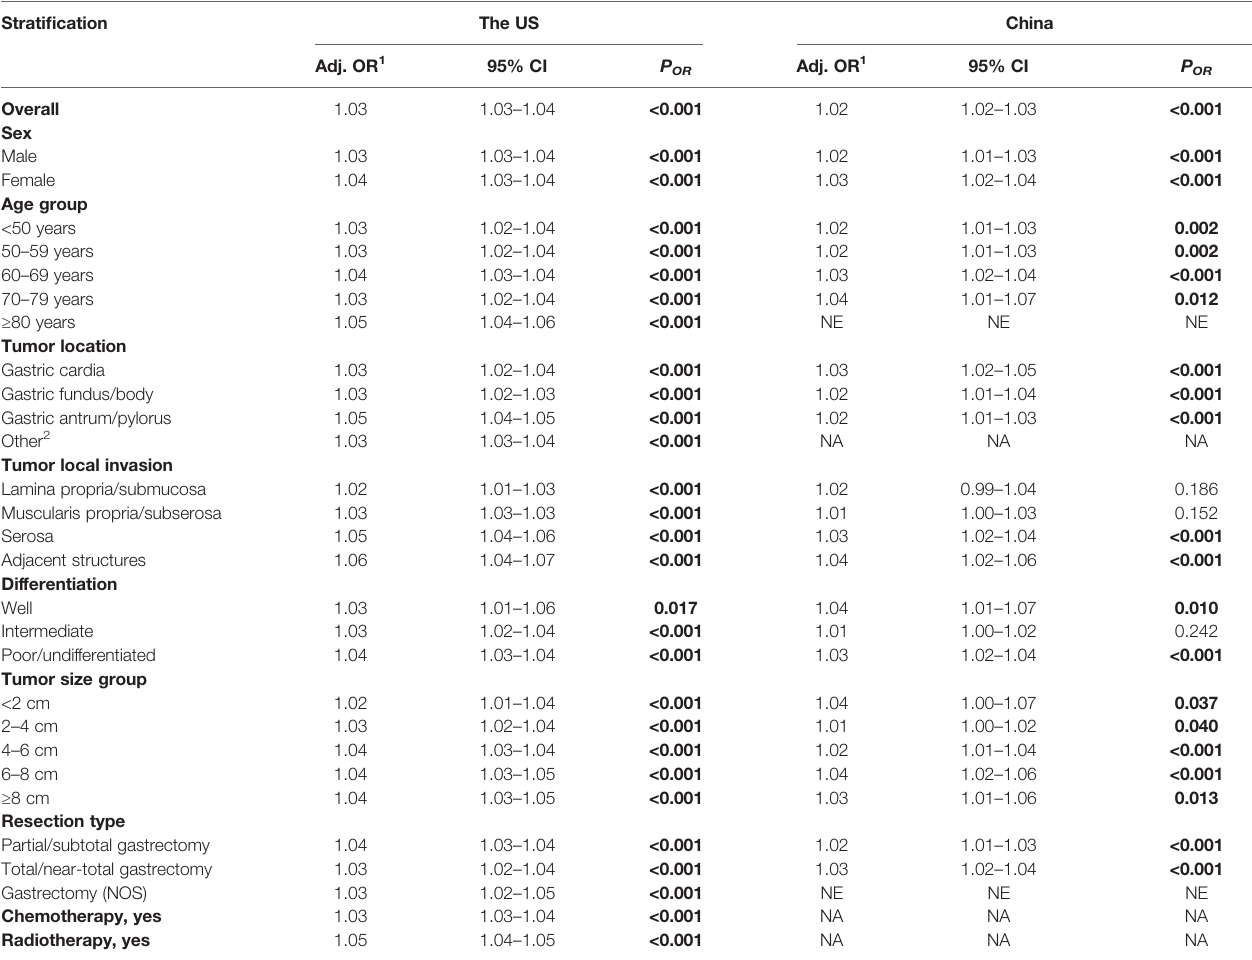
1 Odds ratios for association of examined lymph node count with serial advancement in nodal stage overall and in strati fi cations were computed using multivariable multinomial logistic regression models adjusting for year of diagnosis, sex, age, tumor location, local invasion, differentiation, size, and resection type. Subgroup analyses were performed by stratifying the modelsbypatient,tumor,andtreatmentfactorslistedin Table1 .Insubgroupanalyses,weaddedthecorrespondingcategoryrestrictioninsex,agegroup,tumorinvasion,localinvasion, differentiation, size group, resection type, chemotherapy, or radiotherapy to the overall eligible patients. For example, when conducting subgroup analysis for male patients, we further restricted the overall eligible patients to males. Statistically signi fi cant P values are shown in bold. 2 Lesser curvature, greater curvature, overlapping lesion of stomach, and stomach (NOS). Adj., adjusted; OR, odds ratio; CI, con fi dence interval; NOS, not otherwise speci fi ed; NE, not estimable due to small case number; NA, not